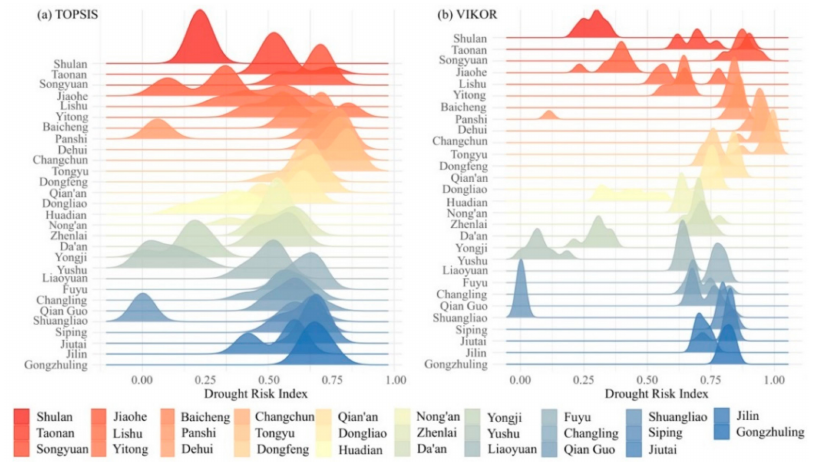
Figure 8. Ridge plot of the drought risk index.